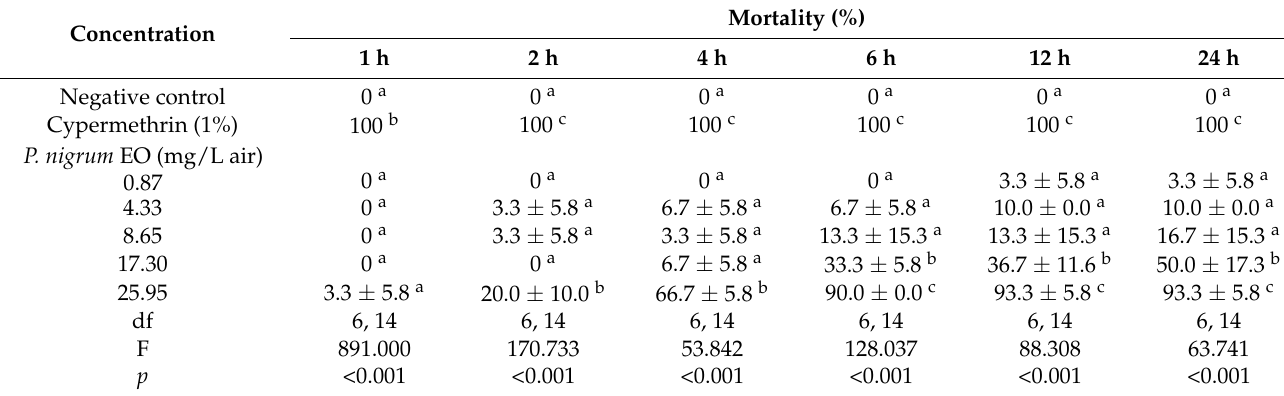
Table 4. Insecticidal activity of Piper nigrum L. essential oil against Stomoxys calcitrans by fumigant toxicity testing.